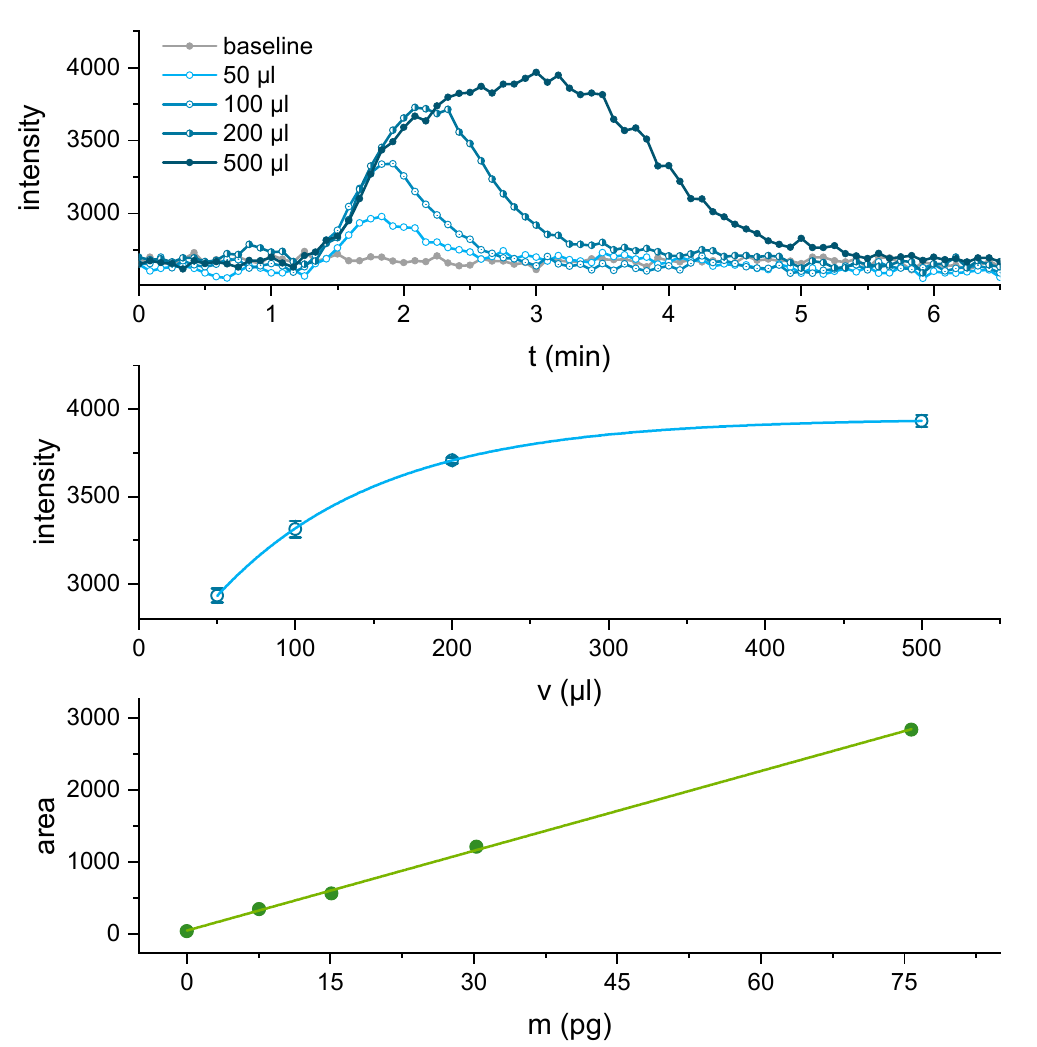
Figure 7. Signals of injection of 50 to 500 µL of 500 pM cocaine ( top ) and obtained signal intensities with standard deviation with an asymptotic fit ( middle ). The peak area is plotted against the injected amount of cocaine (pg) with a linear fit ( bottom ).